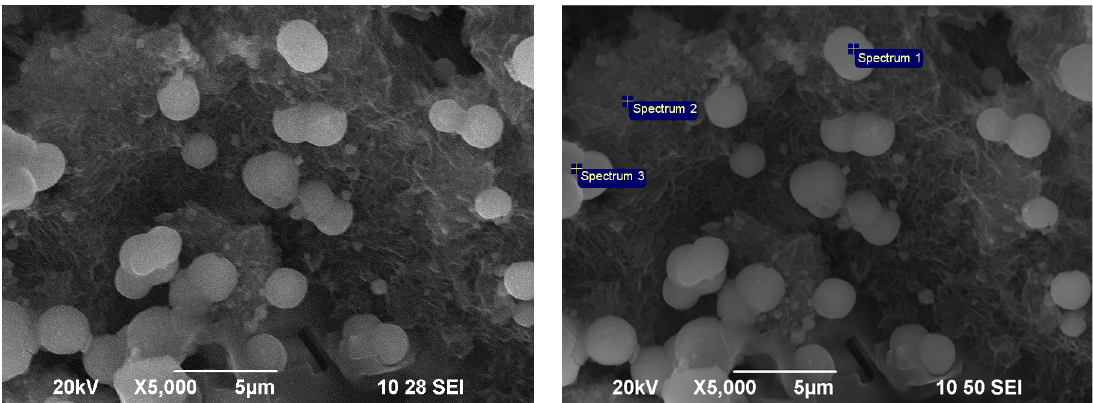
11 of 27 Figure 5. SEM secondary electron image of NZ ( left ) and SZ ( right ) at a magnification of 10,000×.